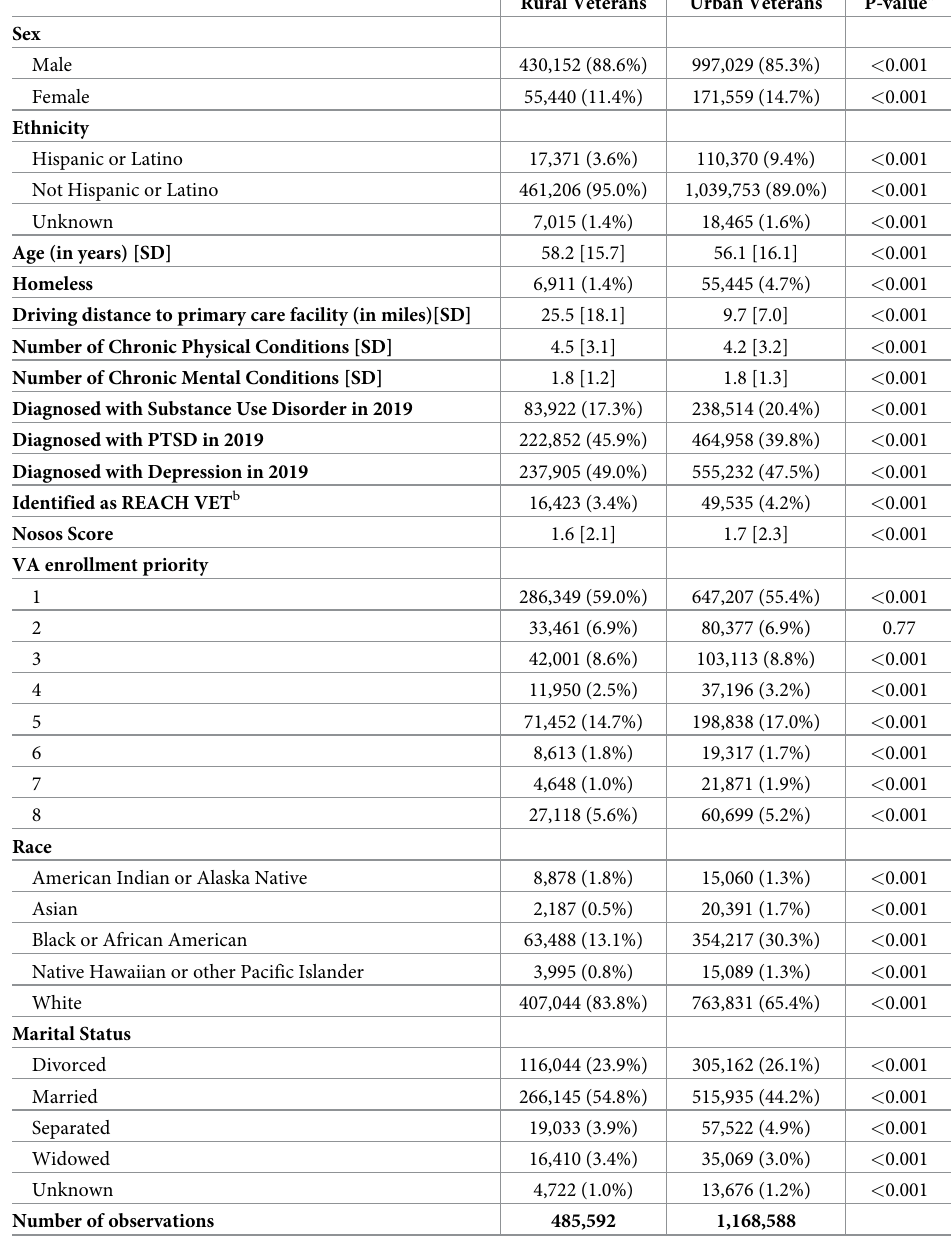
Table 1. Socio-demographic and clinical characteristics of the study cohort, by rurality of